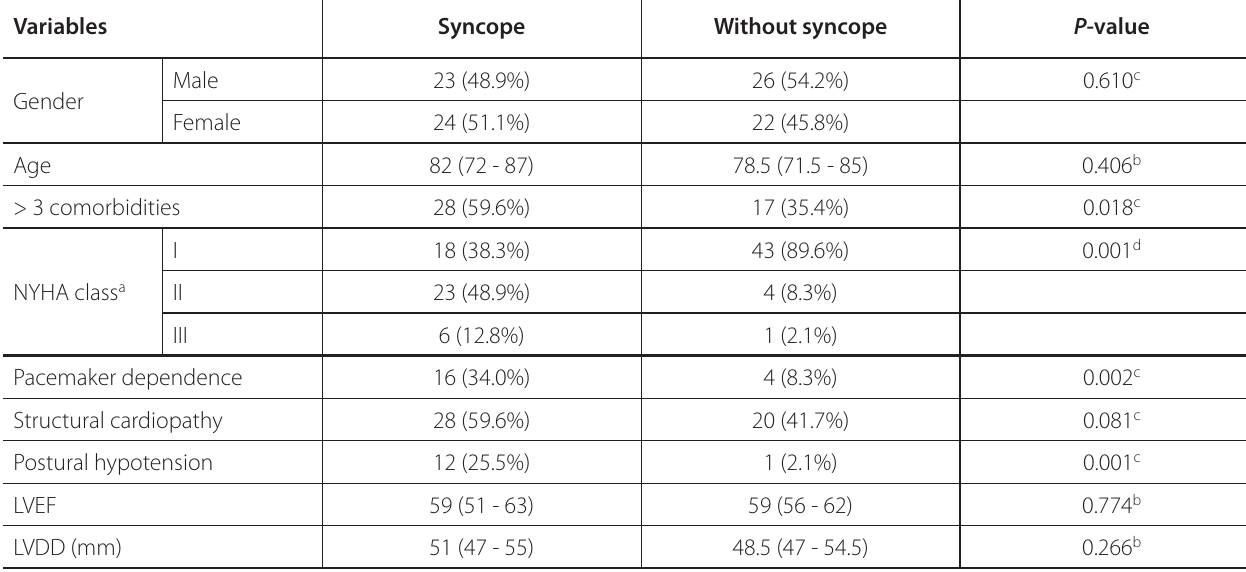
Table 1 . Characteristics of study patients (n=95).